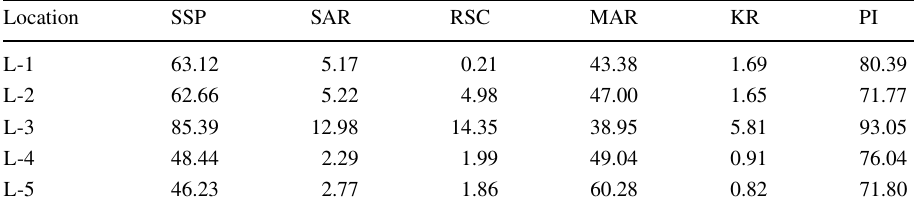
Table 2 Water quality indices of groundwater samples of different sampling